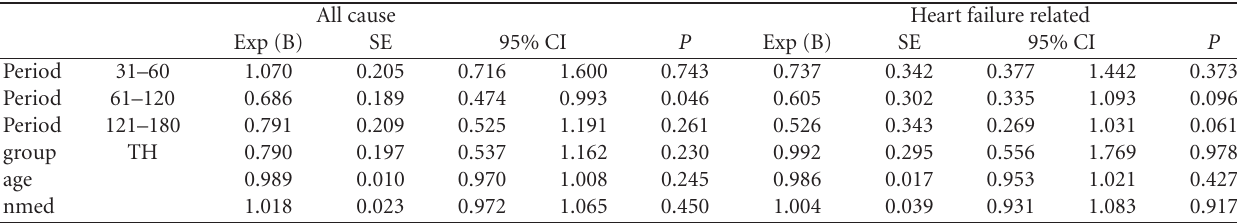
Table 5: Results from GEE model for readmissions.